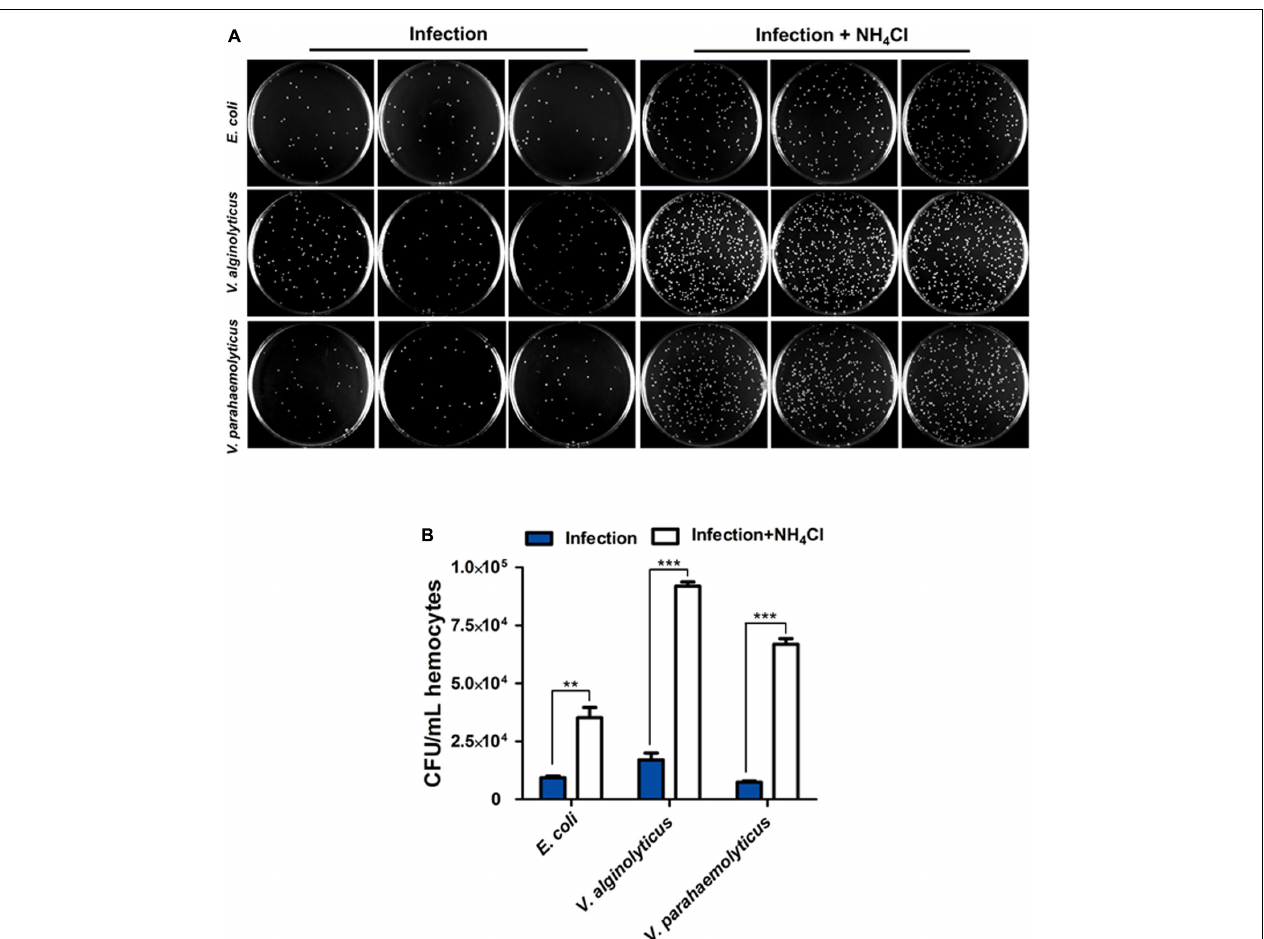
FIGURE 2 | Autophagy contributes to bacteria clearance in hemocytes. (A) Representative agar plating results for infection outcomes with or without treatment of NH 4 Cl as an autophagy blocker. C. hongkongensis hemocytes were exposed to Escherichia coli ( E. coli ), Vibrio alginolyticus ( V. alginolyticus ) or Vibrio parahaemolyticus ( V. parahaemolyticus ). (B) Statistical difference in the extent of bacteria clearance the control and NH 4 Cl groups was determined by Student’s t -test between. Enumeration of bacterial colonies was presented as mean ± SEM ( n = 3 plates), with significance being determined at ** p < 0.01 and *** p < 0.001. Results are representative of three independent experiments.